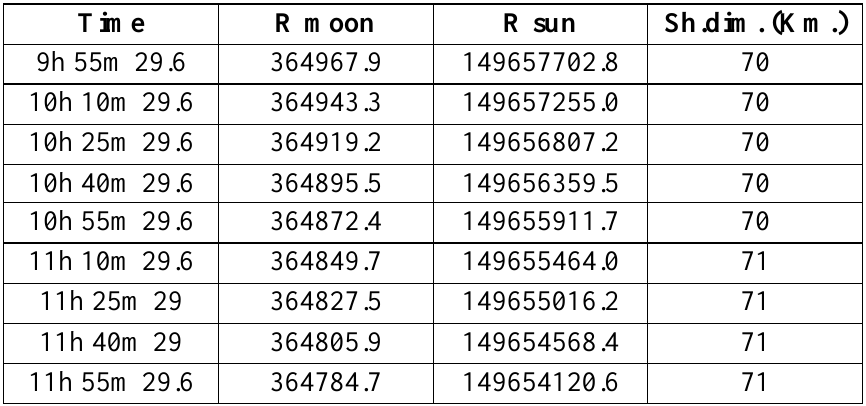
Table 7: YY = .352106190 Total CENTRAL ECLPSE